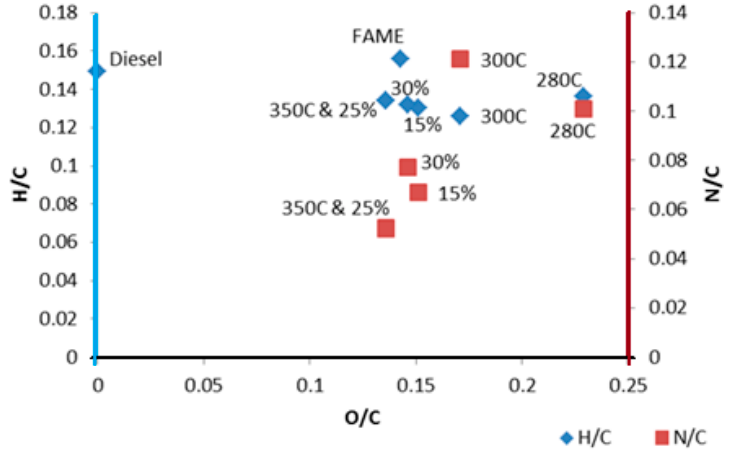
Figure 5. Van Krevelen diagram of bio-crudes gained for different temperatures (280 ◦ C, 300 ◦ C, and 350 ◦ C) and slurry concentration (15%, 20% and 30%) in comparison with diesel and FAME biodiesel standards [53].